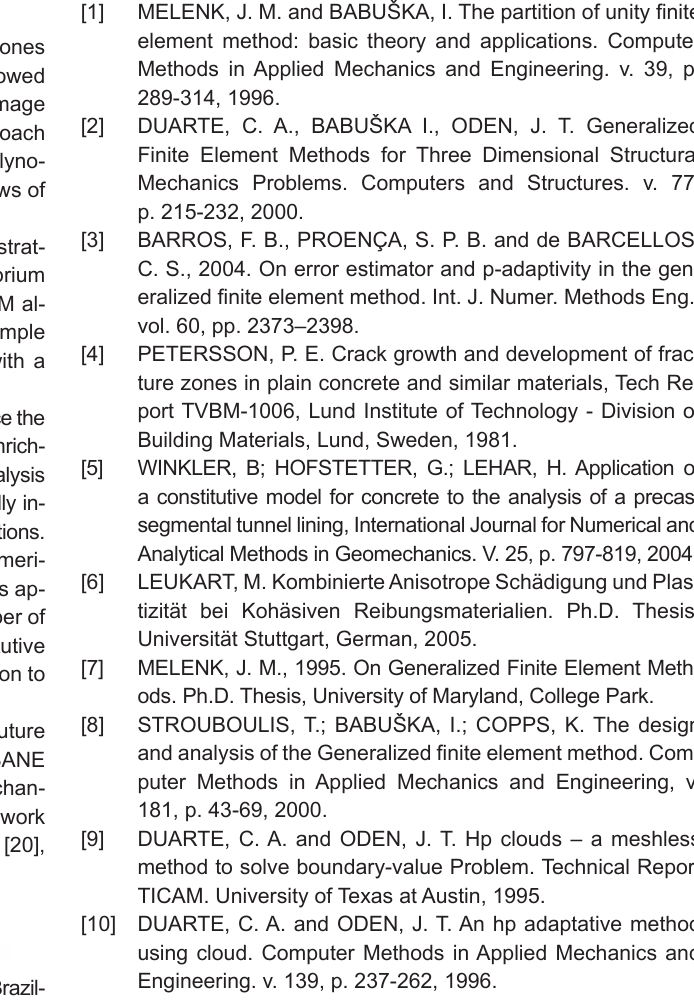
Figure 15 Damage pattern observed by Winkler et al. [5]: (a) experimental and (b) numerical